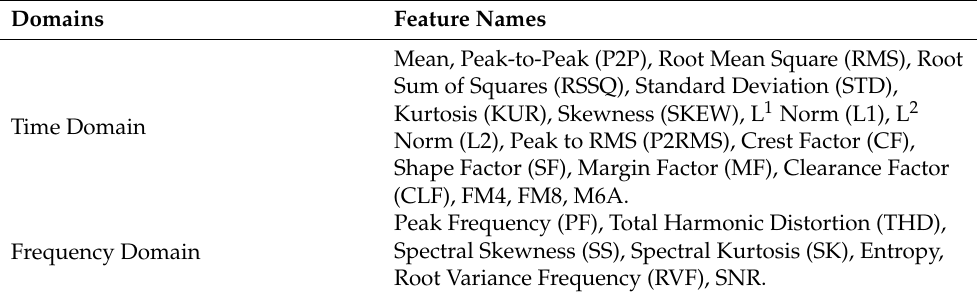
Table 3. The features computed in different dimensions.